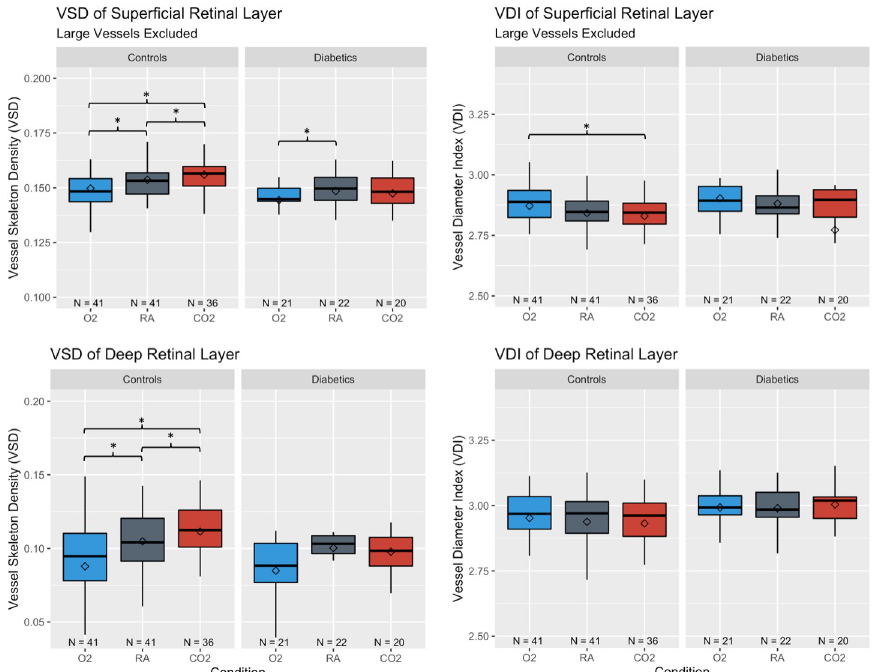
Fig 4. Vessel skeleton density (VSD) and vessel diameter index (VDI) of control and diabetic subjects under gas conditions. Whiskers indicate highest or lowest point within 1.5 times the interquartile range from the upper or lower quartile. Diamonds indicate the mean. Stars indicate significance for pairwise comparison between conditions from the ANCOVA model based on Bonferroni adjusted p-value of 0.017.